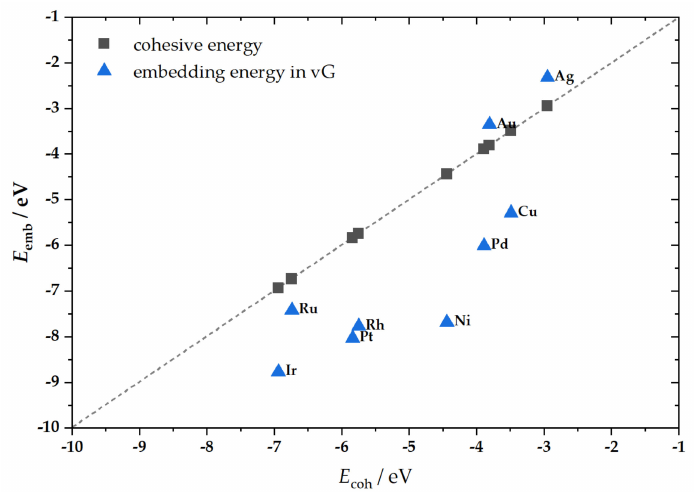
Figure 2. The correlation between embedding energies ( E emb ) of SA in vG and the cohesive energies ( E coh ) of corresponding bulk metal